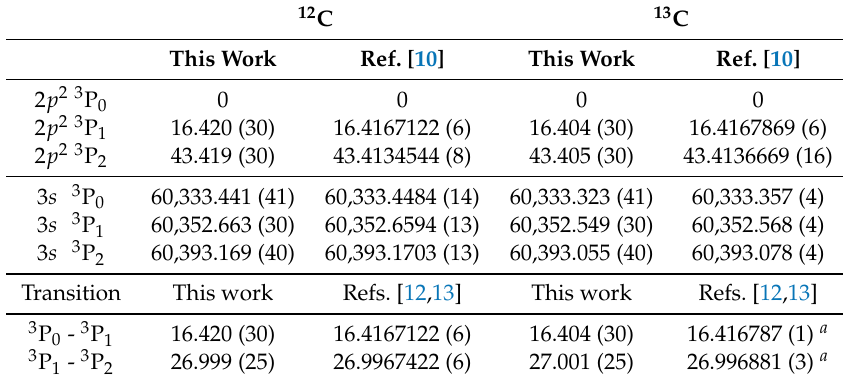
Table 4. Least-squares fitted C I level energies for the 3 P J – 3 s 3 P J multiplet and the comparison with [10]. The predicted transitions between ground 3 P J are compared with the high precision measurements in